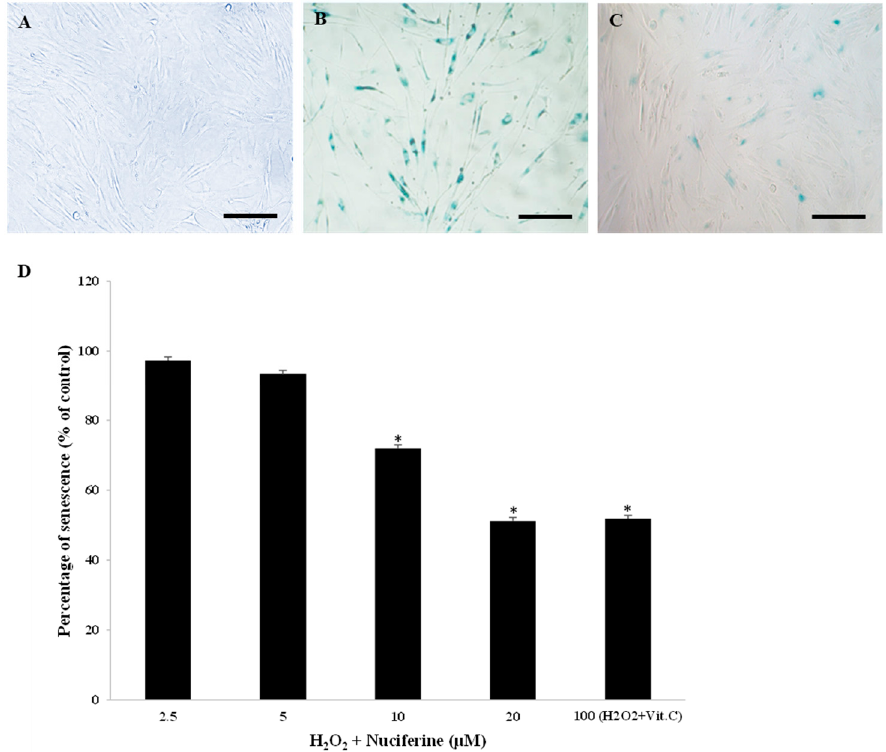
Figure 2. Preventive effect of nuciferine on H 2 O 2 -induced fibroblast senescence. Representative microscopic ß -galactosidase-positive fibroblasts (scale bar = 200 µ m). ( A ): The absence of blue cells indicates fibroblasts with non-senescence activity (negative control). ( B ): Fibroblasts receiving H 2 O 2 (300 µ M) show a massive senescence activity (many blue cells) (positive control). ( C ): A small number of senescent cells can be seen in fibroblasts treated with H 2 O 2 and nuciferine (20 µ M). ( D ): The percentage of senescence was calculated after co-incubation with H 2 O 2 and nuciferine (0–20 µ M) or vitamin C (100 µ M). Mean ± SEM from triplicate independent experiments, * indicates p < 0.05 of one-way ANOVA.